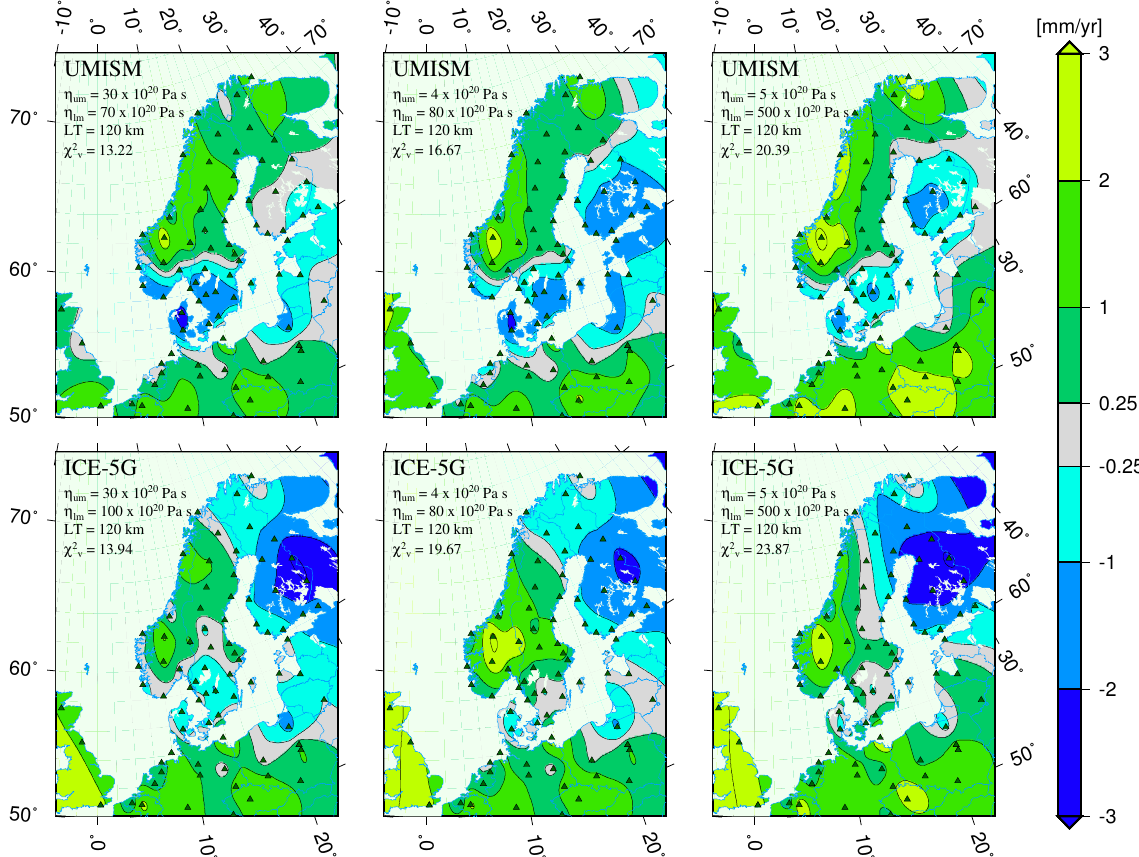
Figure 9. Residual vertical velocities after subtraction from the Bifrost observations of selected well-fitting uniform viscosity models of UMISM (upper row) and ICE-5G (lower row). Negative residuals (blue colours) indicate too-fast predictions. Earth model parameters are shown in the legends. Also shown are observed (yellow vectors) and predicted (red vectors) horizontal velocities, the latter adjusted by a rigid rotation as explained in Lidberg et al.